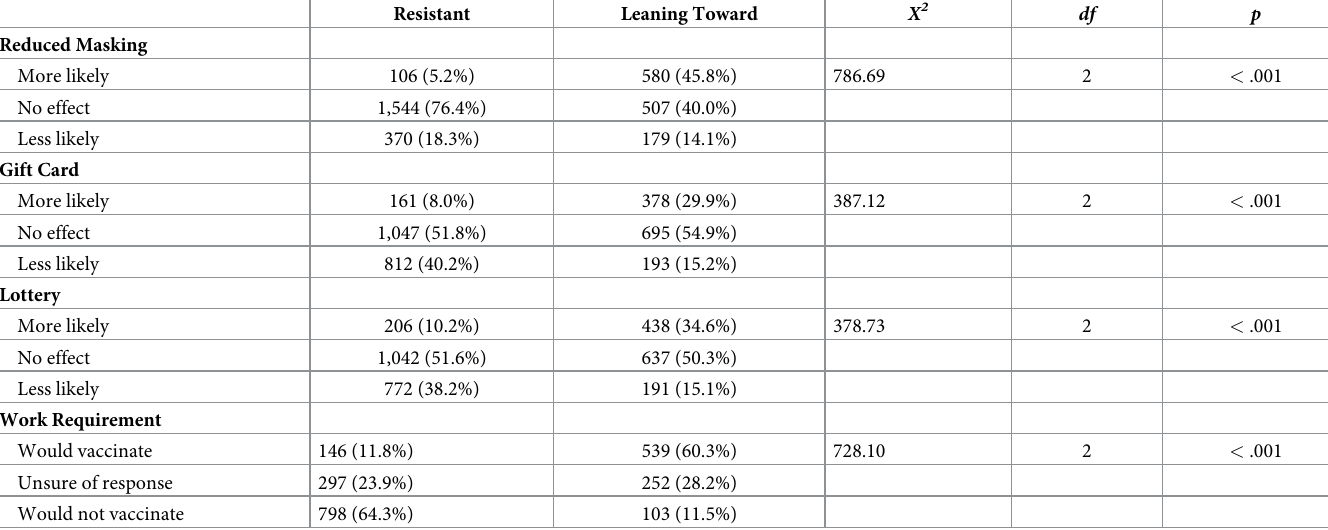
Table 3. Chi-square analyses predicting impact on vaccination intention by general vaccination intention